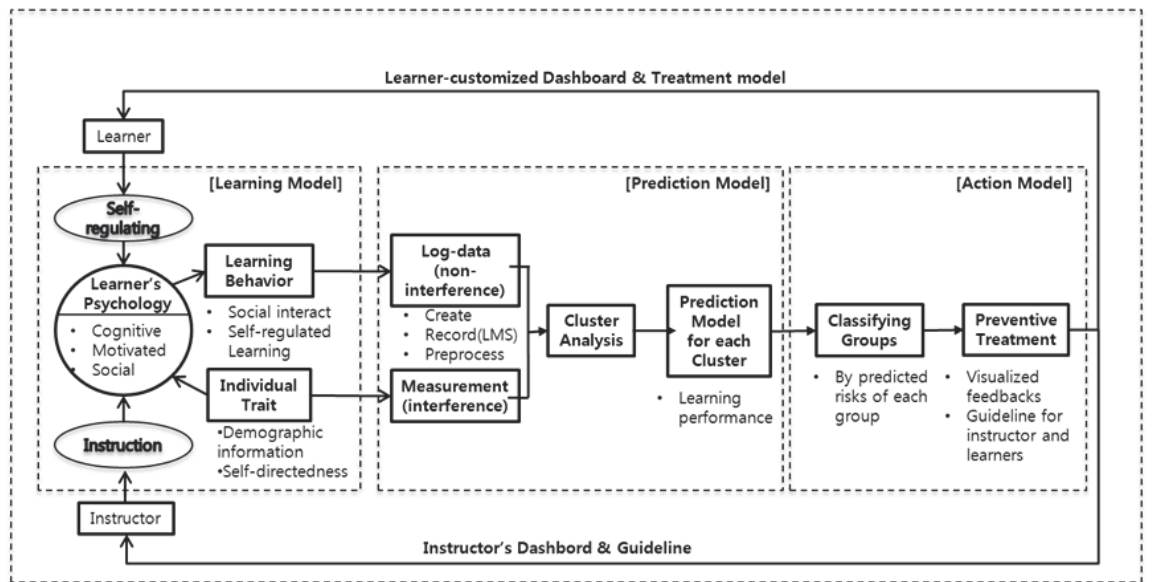
Figure 1. Learning Analytics for Prediction and Action Model (Jo,